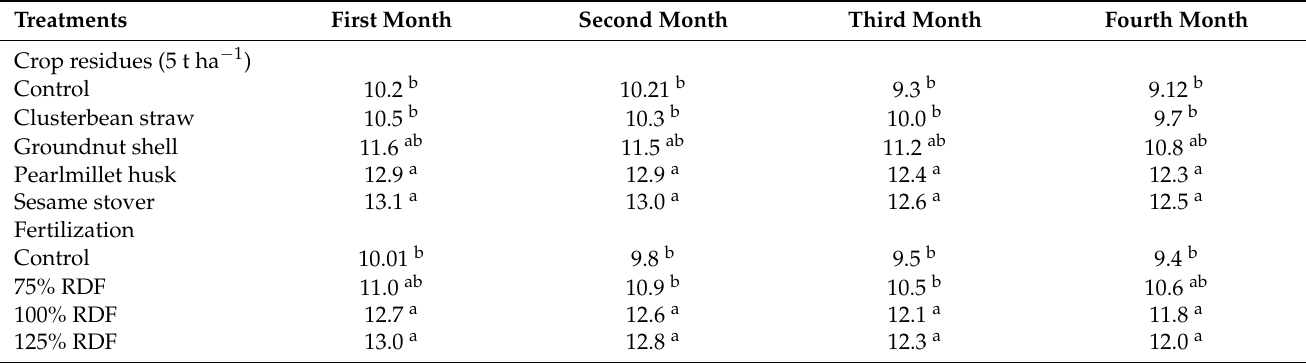
Table 3. Effect of crop residues and fertilization on alkaline phosphatase enzyme activity ( µ g PNP produced g − 1 soil h − 1 ) at first, second, third, and fourth month after sowing.